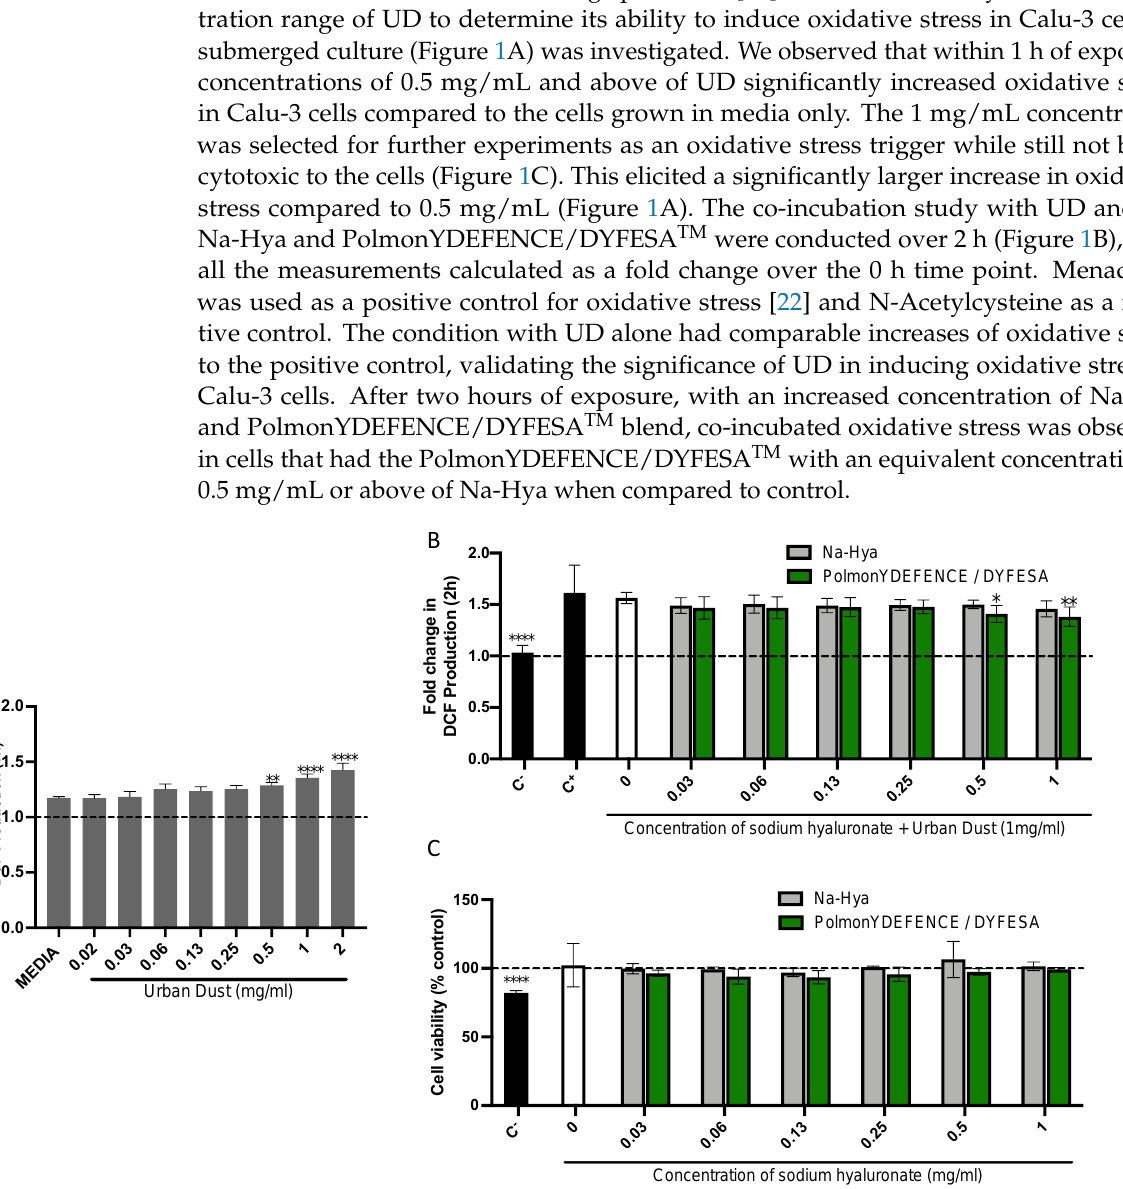
Figure 1. The induction of ( A ) oxidative stress induced by environmental pollutant (urban dust) in Calu-3 cells grown in submerged culture. Statistical significance was calculated by comparing all conditions to media. ( B ) Co–incubation study at 2 h exposure to urban dust and a concentration range of Na-Hya (light grey) and PolmonYDEFENCE/DYFESA TM (green). Statistical significance was calculated by comparing urban dust only to every other condition. ( C ) Cell viability assay using the 2 h exposure of Calu-3 cells to the compounds. An ordinary One-Way ANOVA with Sidak’s multiple comparisons test was used (* p < 0.033; ** p < 0.0021; **** p < 0.0001). Further, we conducted a cytotoxic assay using the 2 h exposure model (Figure 1C) to rule out the observed decrease in oxidative stress due to the percentage of viable cells. Our data showed that the sodium hyaluronate present in the PolmonYDEFENCE/DYFESA